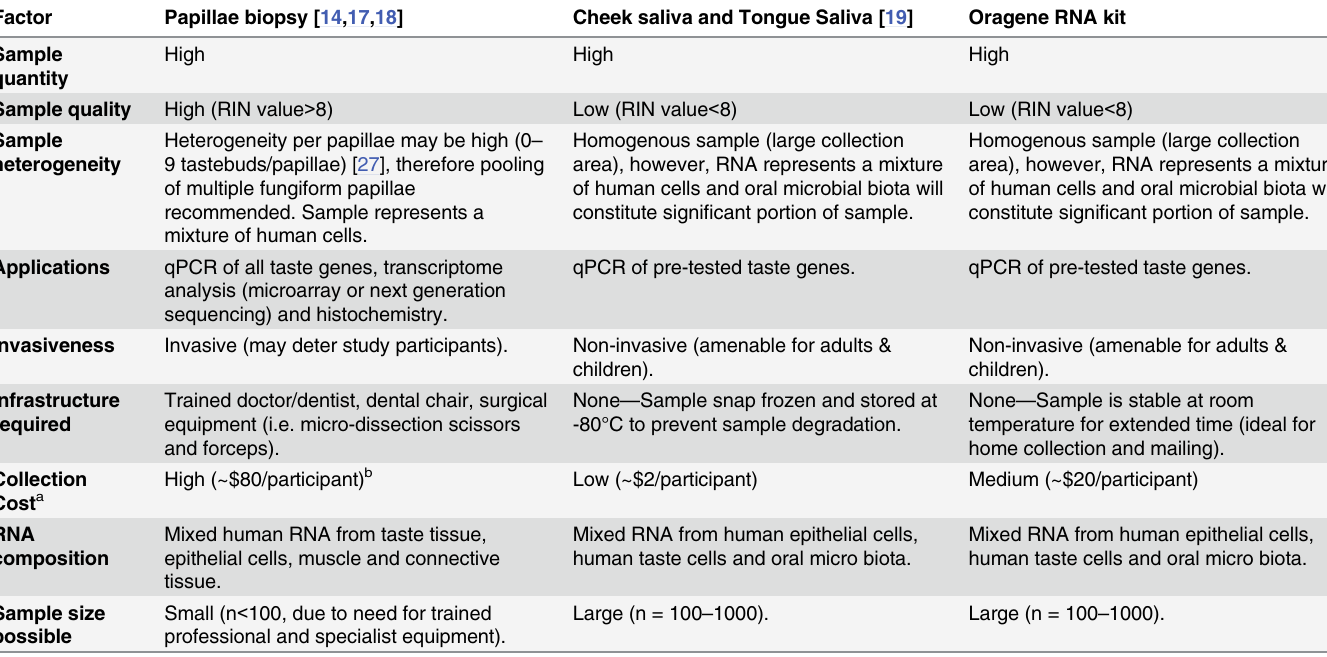
Table 4. Comparison of collection techniques (advantages and disadvantages) for the analysis of quantitative taste gene